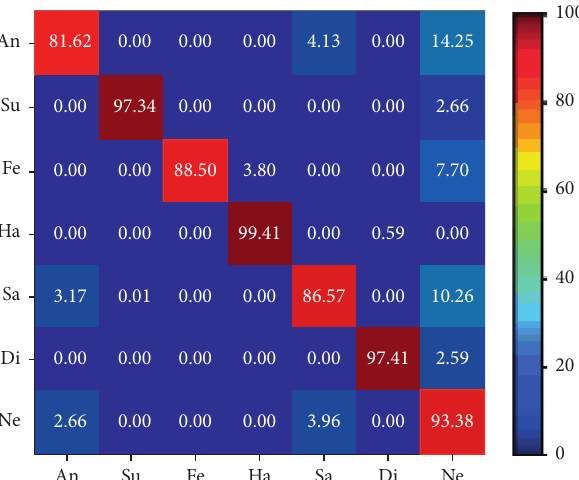
Figure 9: The confusion matrices on CK+